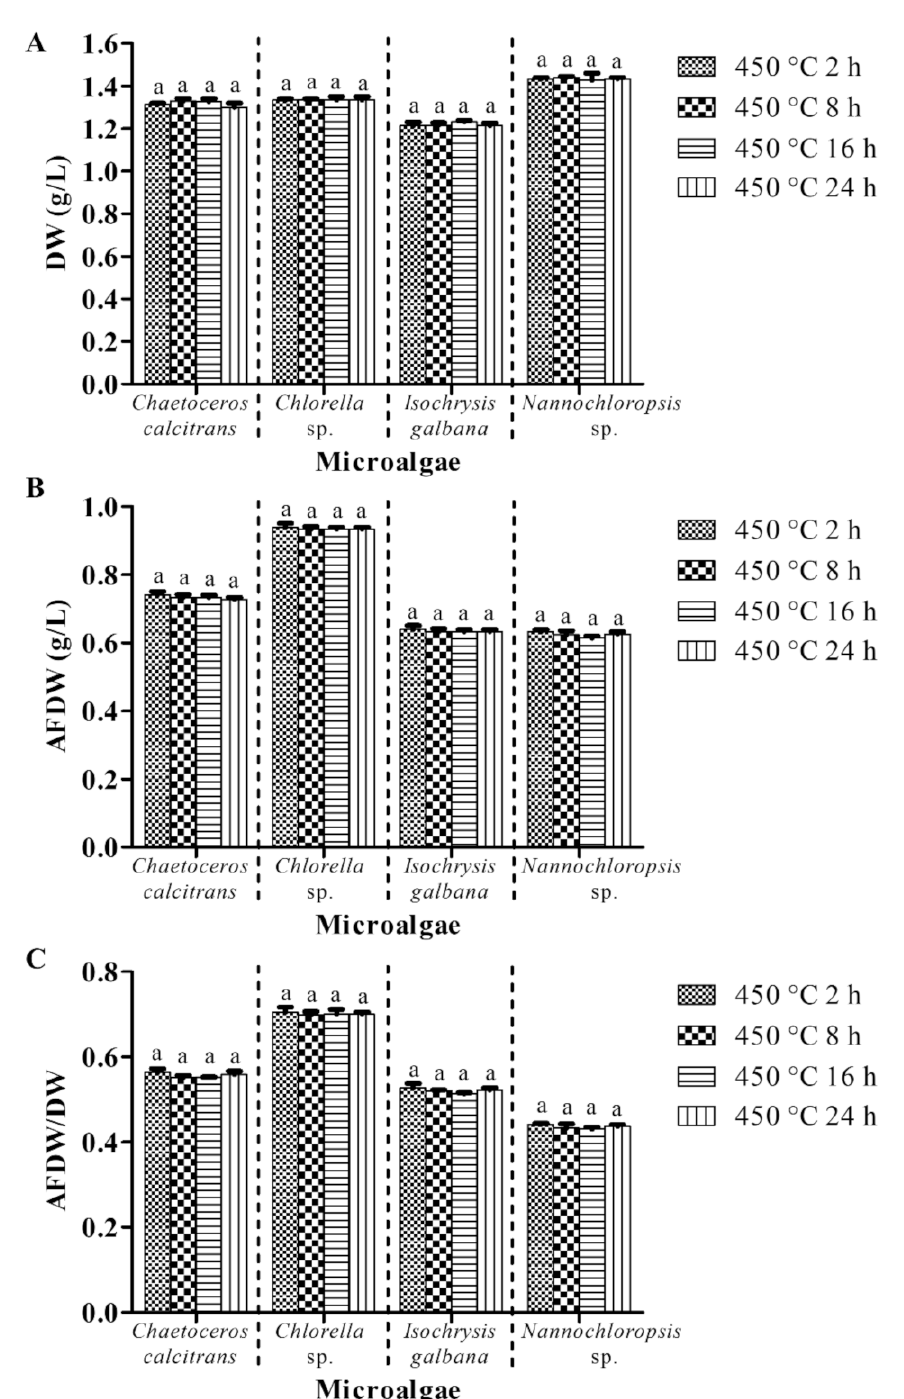
Figure 4. Biomass of four different marine microalgae subjected to glass microfiber filter that pre- combusted at different exposure periods. ( A ) dry weight ( B ) ash-free dry weight ( C ) ash-free dry weight/dry weight. The other parameters were unchanged (with washing process; GF/A; pretreat- ment of GMF at 450 ◦ C; 0.5 M ammonium formate; 1:1 culture: washing agent ratio; one washing cycle). Different letters for the respective microalgae indicate statistically significant differences ( p < 0.05) in terms of biomass among the glass microfiber filters that precombusted at different expo- sure periods. DW, dry weight; AFDW, ash-free dry weight. Data are expressed as mean ± standard error (n =